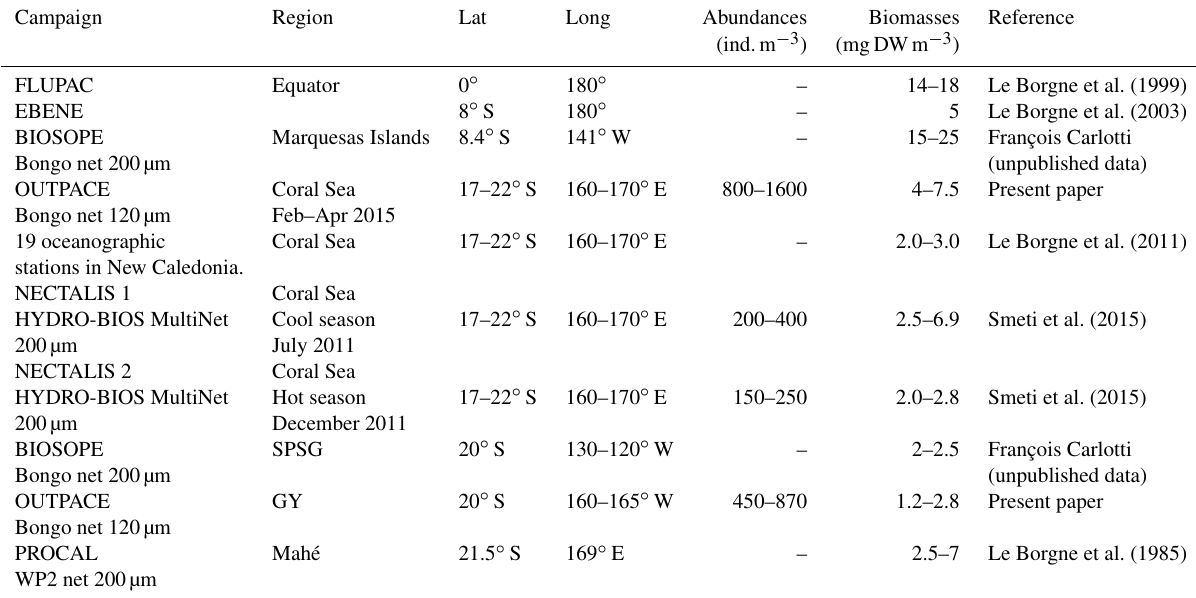
Table 7. Average zooplankton abundance and biomass values from different regions of the western and central tropical South Pacific around the 20th parallel